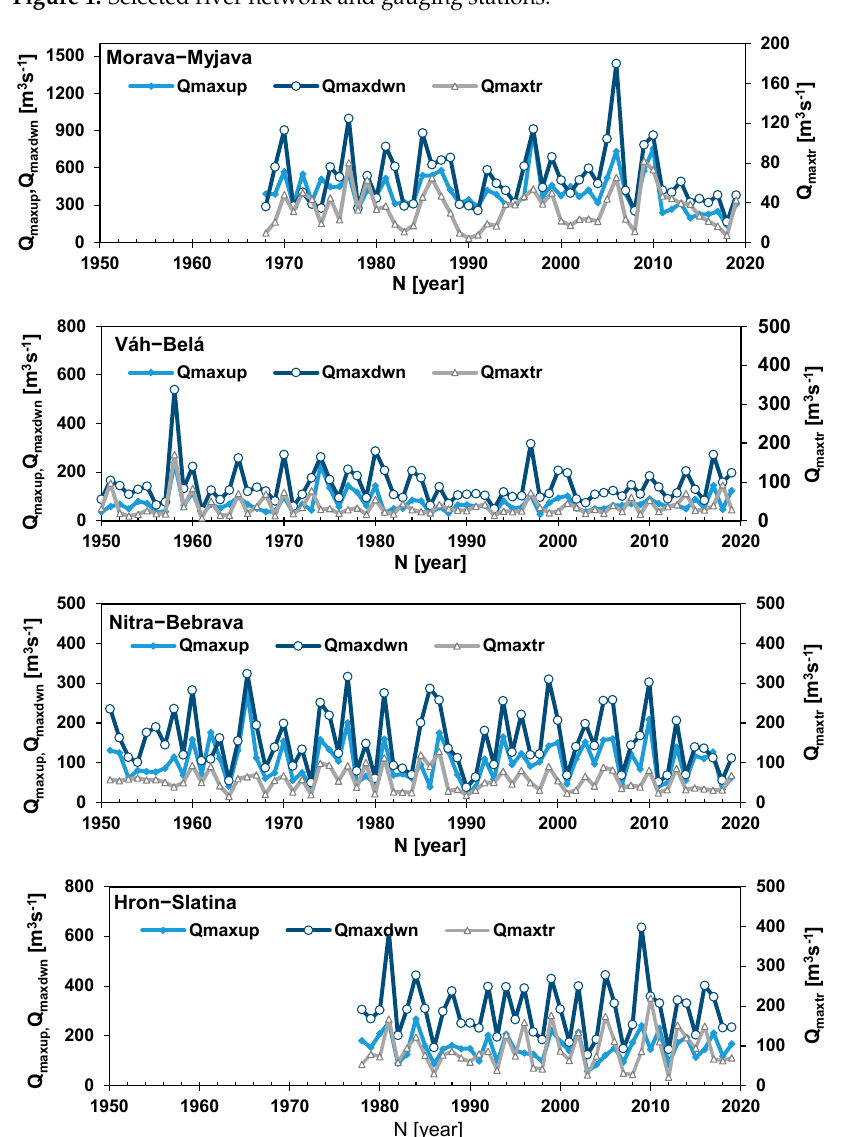
Figure 2. Maximum annual discharges for the mainstreams and their tributaries during the analyzed periods: Morava–Myjava, V á h–Bel á , Nitra–Bebrava,